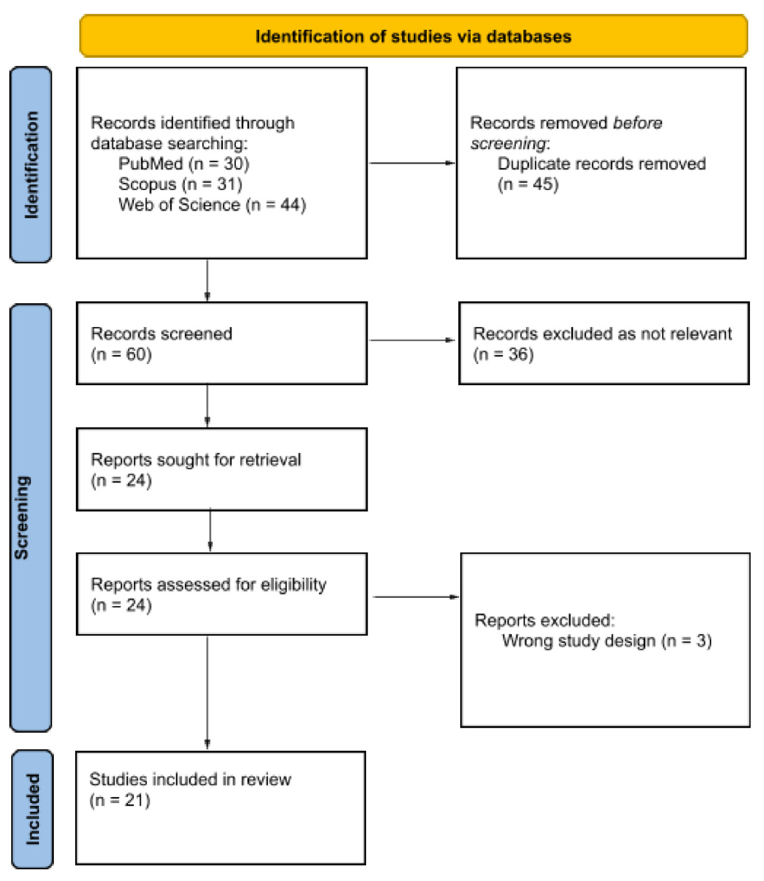
Figure 1. Flow diagram of studies assessed in systematic review. Diagram shows several steps of studies selection in systematic review, also describing exclusion criteria and final number of included articles for each step. Table 1. Reported cases of hidradenitis suppurativa in individuals with HIV.